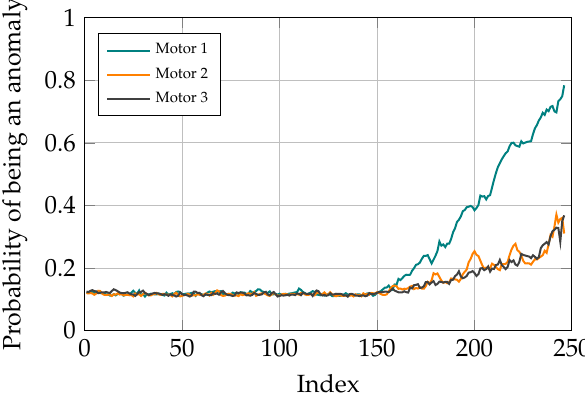
Figure 13. Simulation results with distortion added to motor 1.